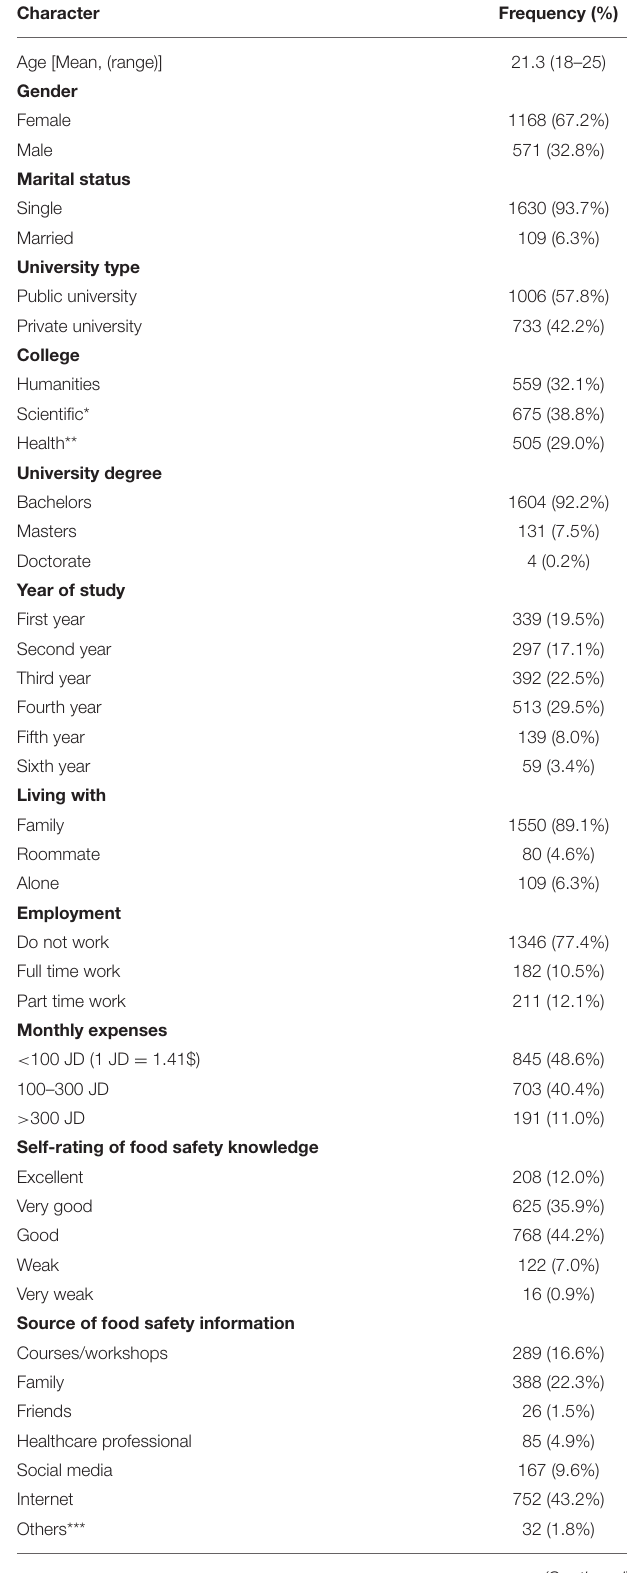
TABLE 1 | Demographic characteristics of university students ( n =